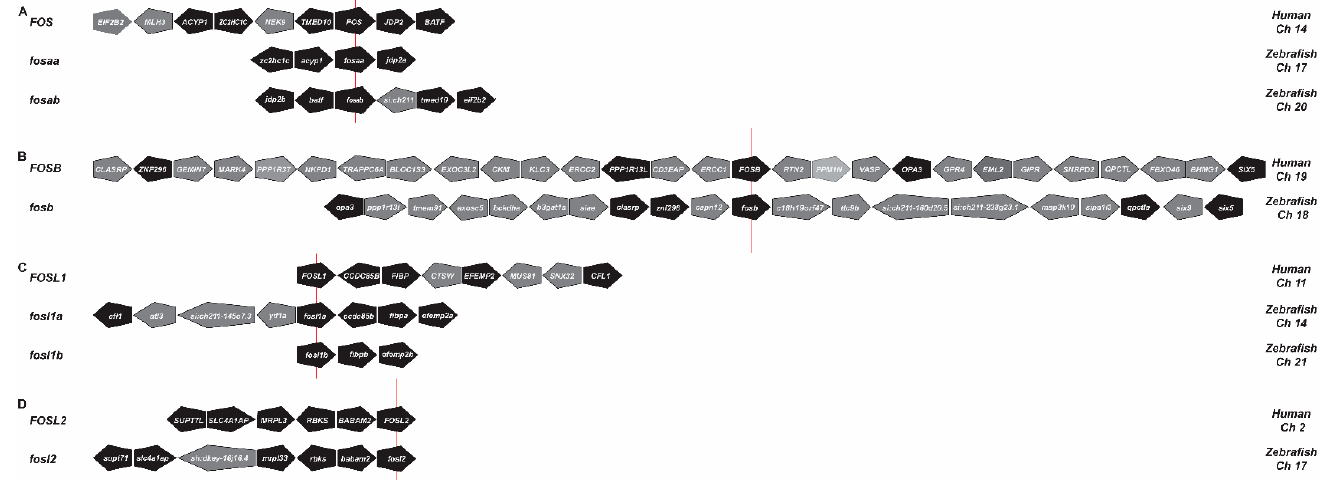
Figure 1. Synteny analysis of FOS genes. Human and zebrafish FOS ( A ), FOSB ( B ), FOSL1 ( C ), and FOSL2 ( D ) gene loci, indicating adjacent genes in their respective orientations. Zebrafish genes that share conserved synteny between human neighbouring genes are shown in black and non-syntenic genes in grey. The red line indicates the reference gene. Ch, chromosome.